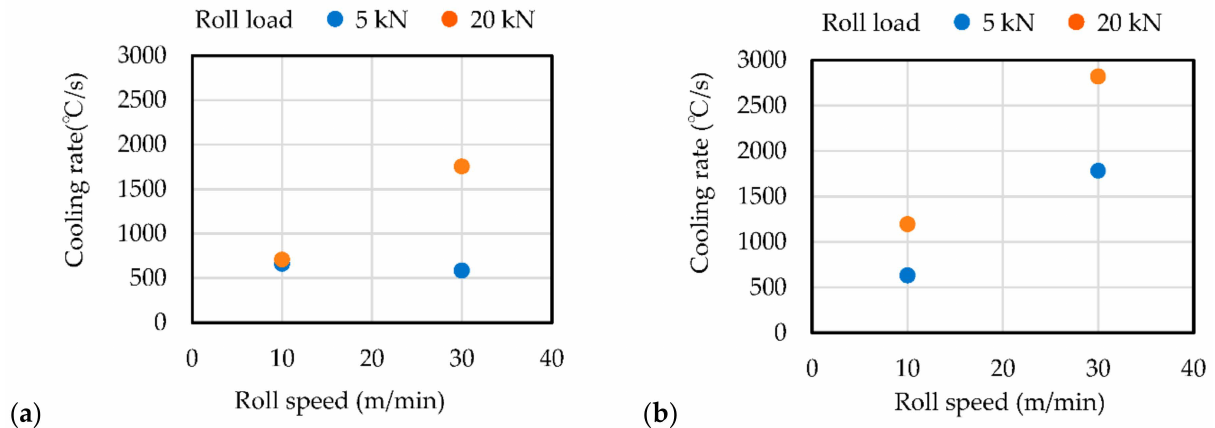
Figure 8. Effects of roll materials on cooling rate. The rolling speed was 10 or 30 m/min, and the roll load was 5 or 20 kN. ( a ) Mild steel roll and ( b ) copper roll.